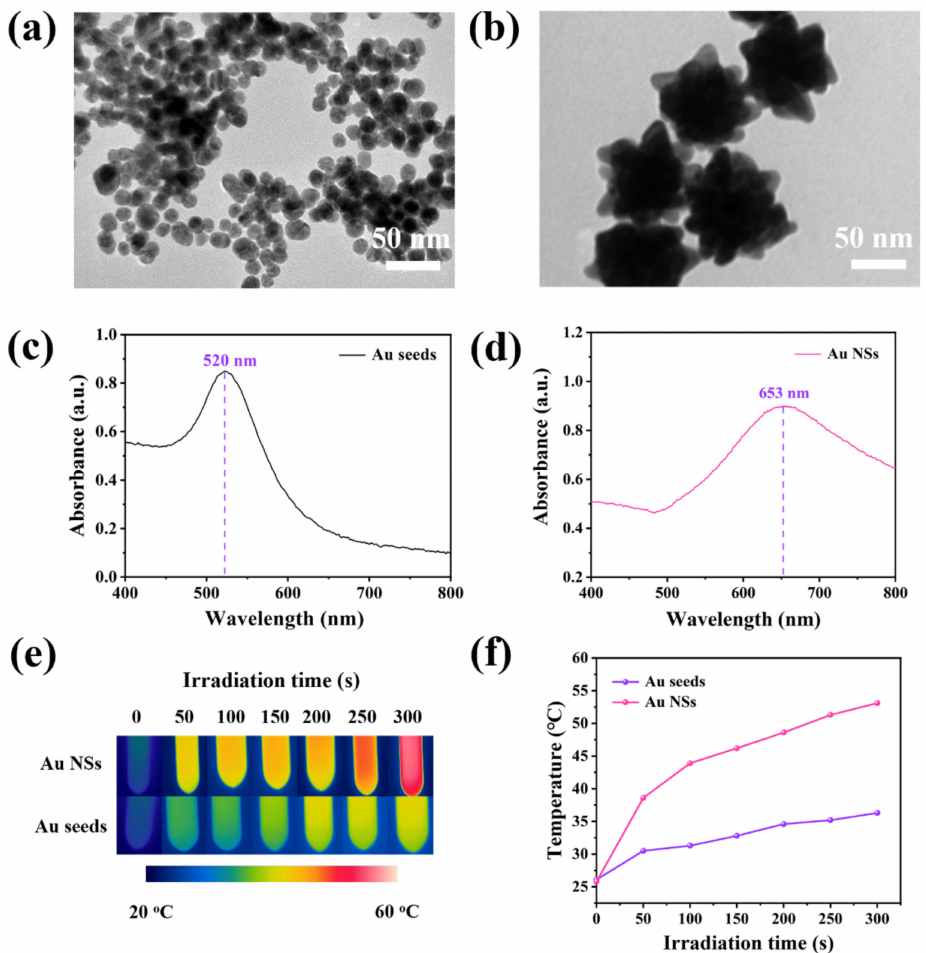
Figure 1. TEM images of ( a ) Au seeds and ( b ) Au NSs, UV-Vis spectra of ( c ) Au seeds and ( d ) Au NSs, ( e ) IR thermal images, and ( f ) corresponding time-dependent temperature curves of Au seeds and Au